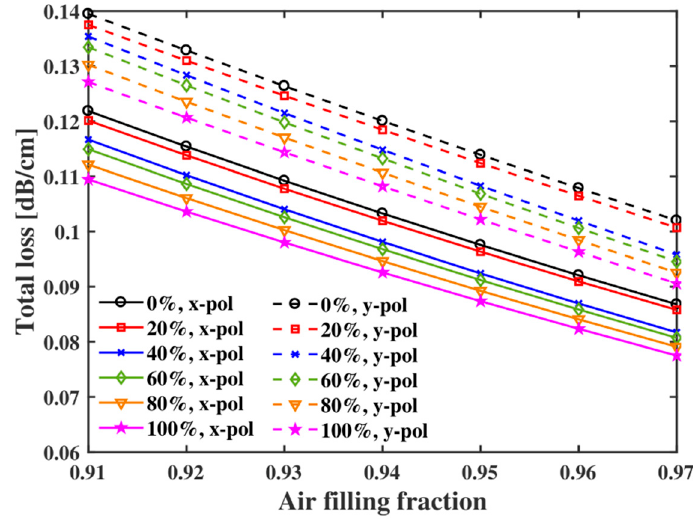
Figure 13. Variation of total loss of that fiber for different AFF at 2.8 THz and L = 280 µm.